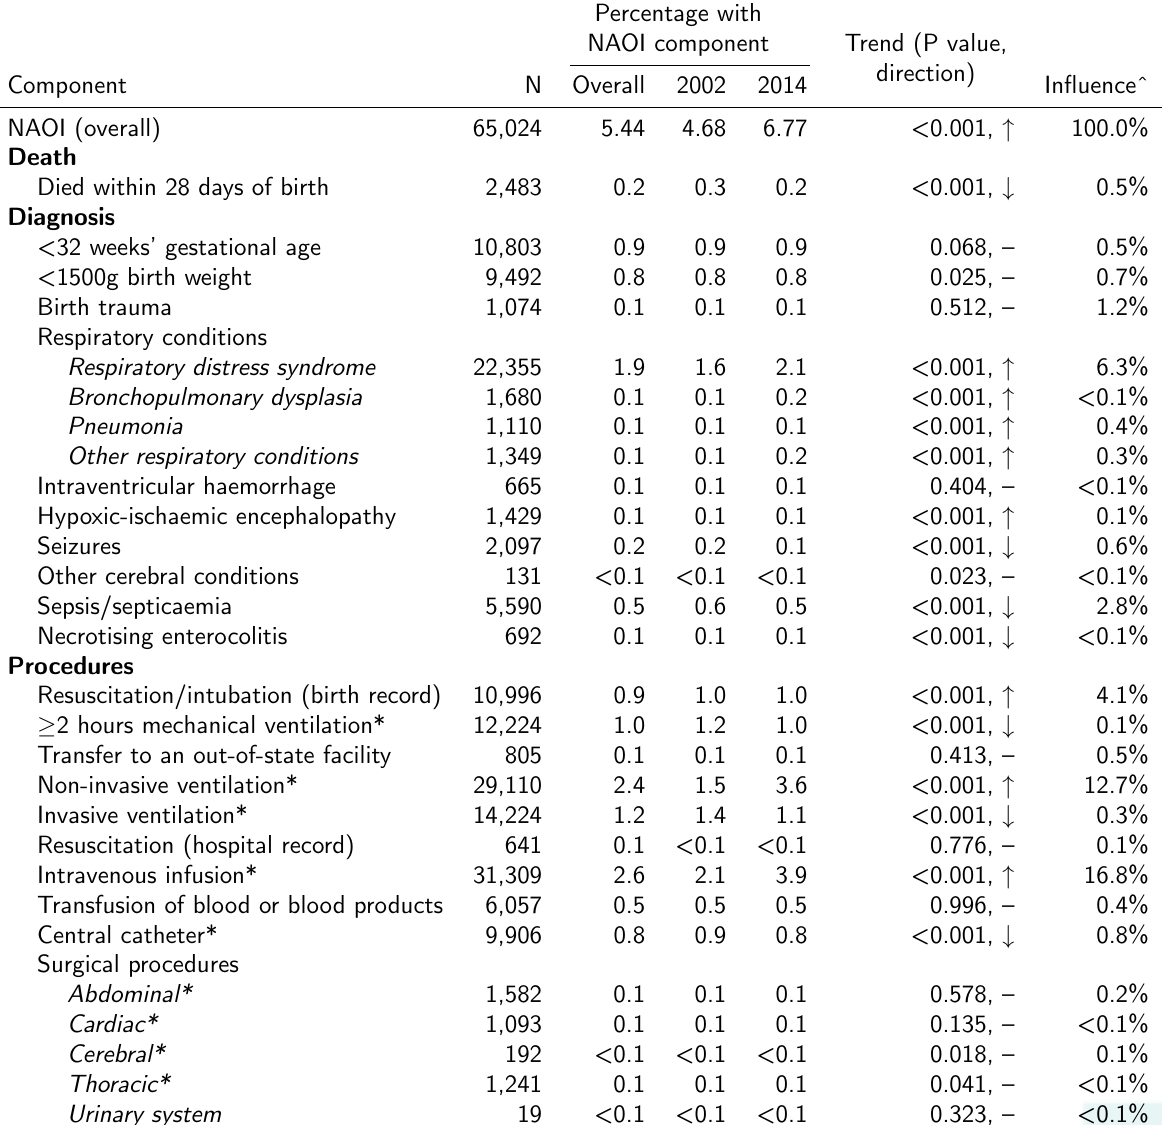
Table 2: Frequency, incidence per 100 births and influence for the neonatal adverse outcome indicator (NAOI) and components. Percentage